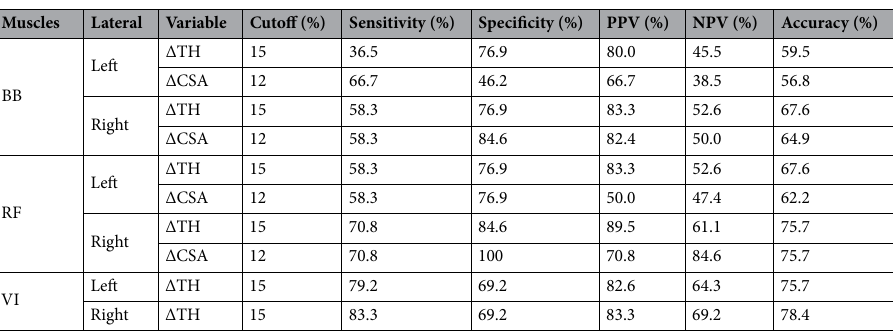
Table 3. Specificity, sensitivity, negative predictive value, positive predictive value and accuracy for defined cutoffs of ΔTH day10 and ΔCSA day10 of muscles. BB, biceps brachii; RF, rectus femoris; VI, vastus intermedius; ΔTH, changes in thickness; ΔCSA, changes in cross-sectional area; PPV, positive predictive values; NPV, negative predictive values.